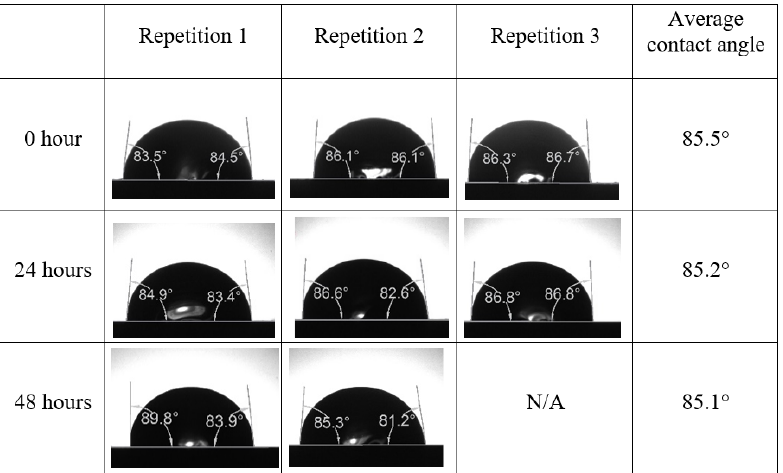
Figure A15. Dynamic Contact Angle Measurement Results for 25% MgCl 2 + 75% Na 2 SO 4 (3500 ppm).